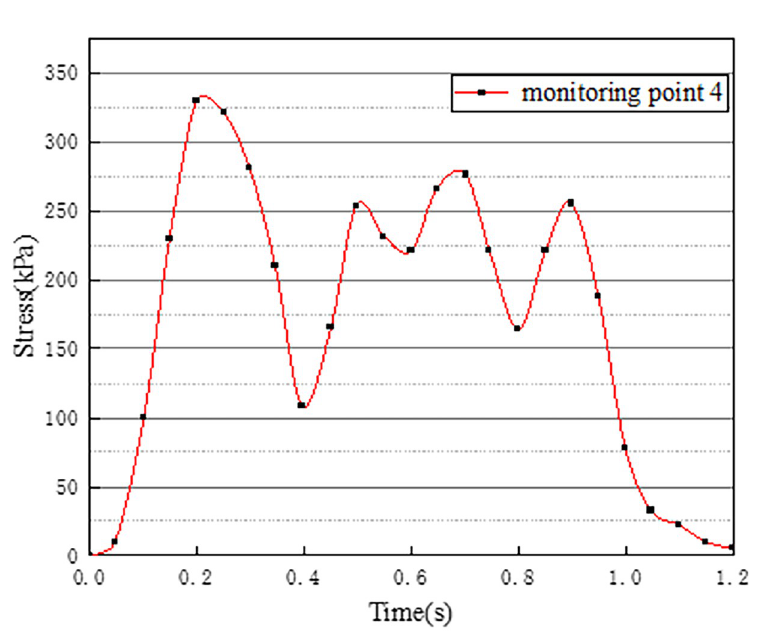
Fig 14. Stress time history curve of monitoring point